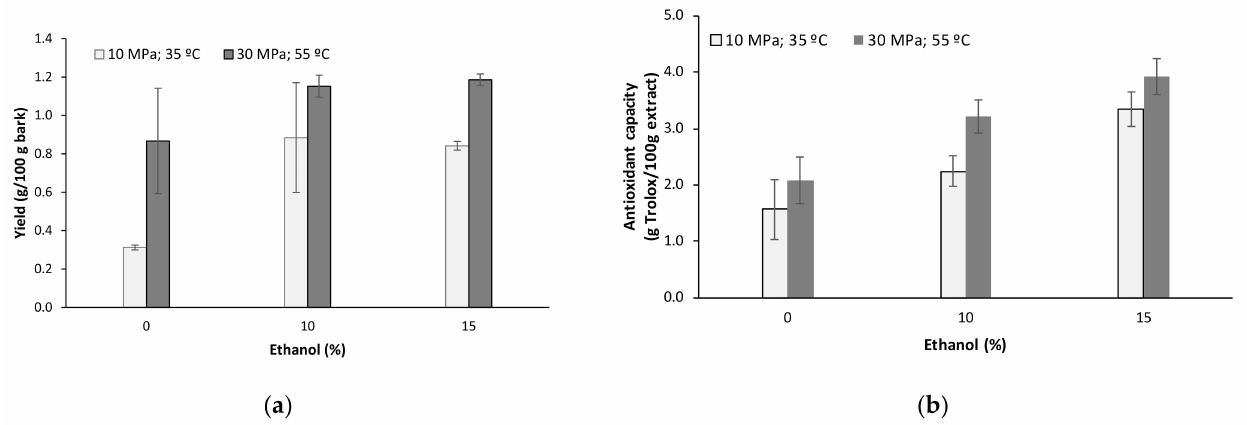
Figure 3. Influence of the ethanol concentration as a modifier on the extraction yield ( a ) and the antiradical properties, determined and TEAC value for ABTS scavenging capacity ( b ) of Paulownia elongata x fortunei bark at 10 MPa, 35 ◦ C (white); and 30 MPa, 55 ◦ C (gray) for 30